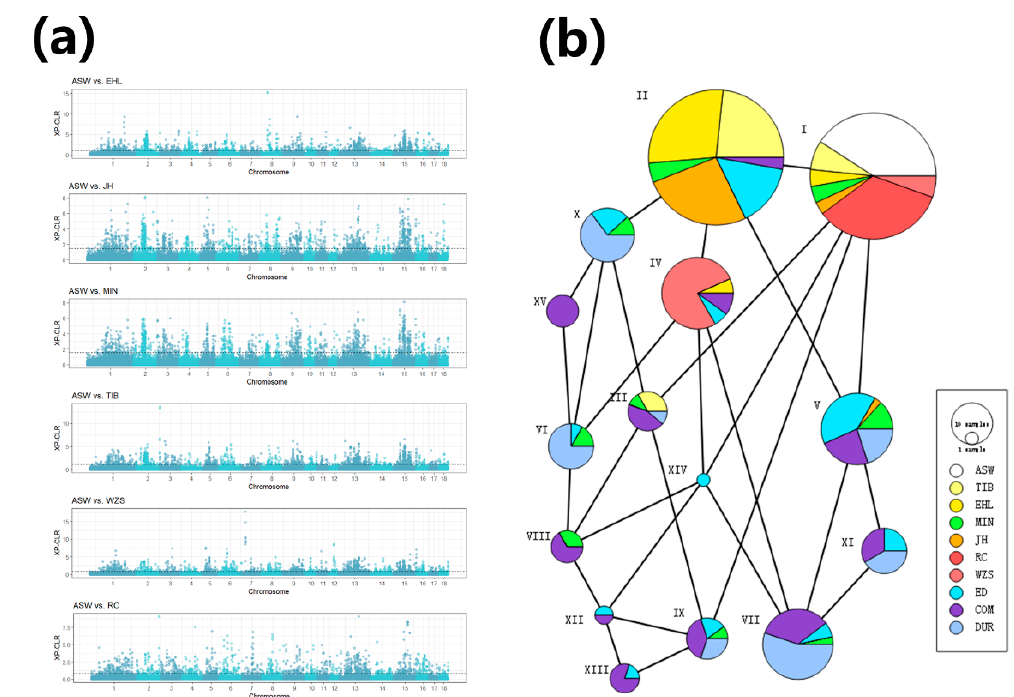
Figure 3. ( a ) XP-CLR (cross-population composite likelihood ratio) values calculated between each indigenous Chinese breed vs. Chinese wild boars. The black dashed lines represent the 5% cutoff used to define selective signals. ( b ) Haplotype network generated using 15 common haplotypes in chr13: 12.5–13.1Mb. Circle area is proportional to the number of samples, and lines between the circles represent a step mutation.